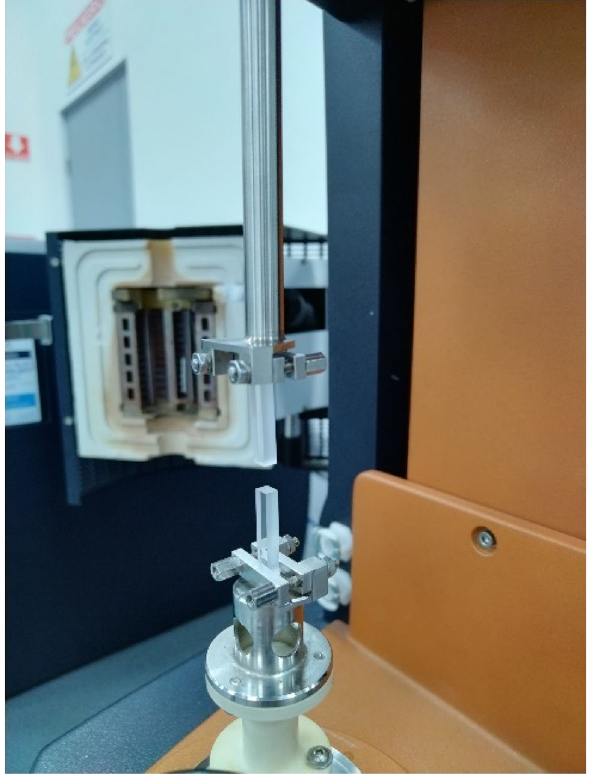
Figure 8. Photograph (taken by the authors) of the pull-off assembly glass blocks used clamped to the rectangular geometry from the DMTA (Discovery HR-3/Hybrid Rheometer, TA